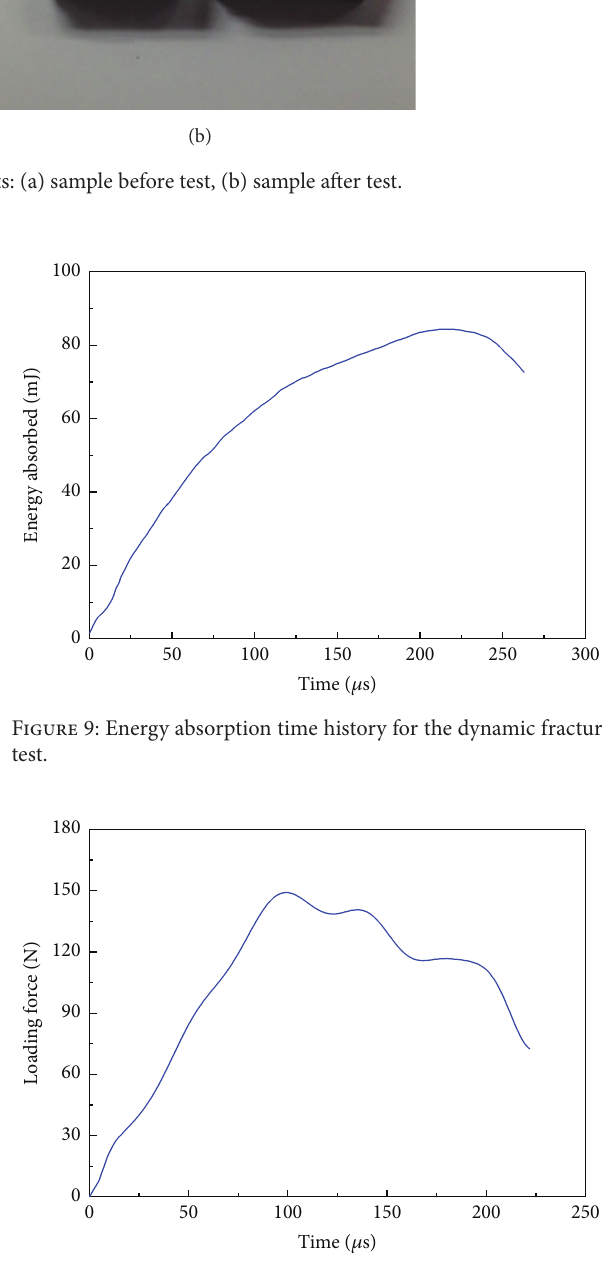
Figure 10: Loading force-time history for the dynamic fracture